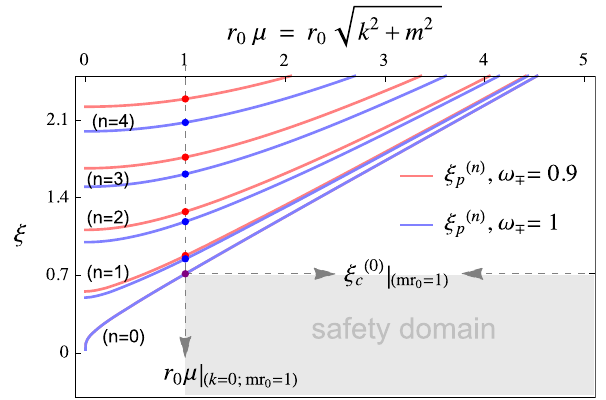
Fig. 2 Safety domain, in grey, for the massive coupled scalar field Green’s function in symmetric thin-shell wormhole backgrounds with mr 0 = 1. If ξ < ξ ( 0 ) c the configuration is stable ξ < ξ ( 0 ) | mr i = 1 is the stable region for configurations with c positive κ